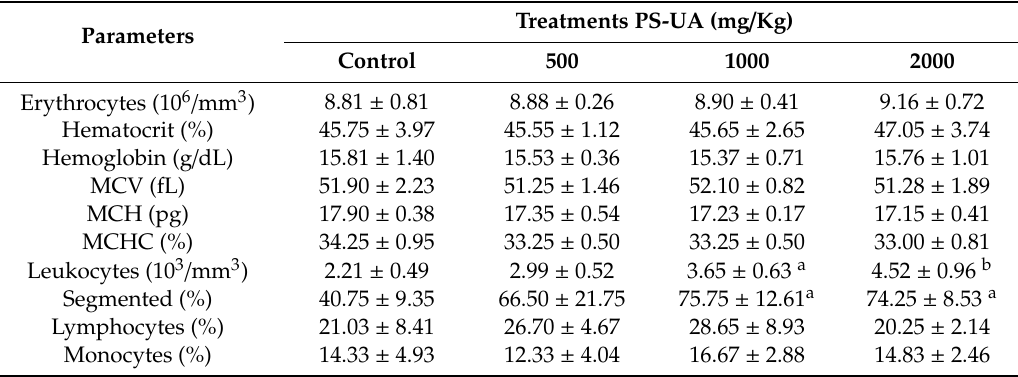
Table 3. The hematological parameters of the blood of mice treated with PS-UA. Parameters